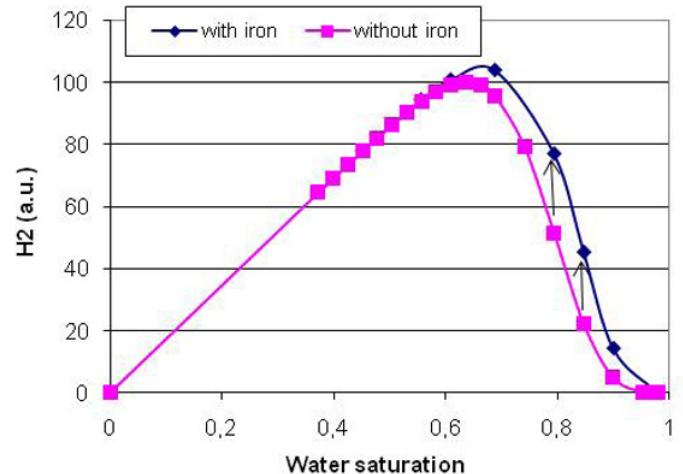
Fig. 5: Dihydrogen production for 100 years as a function of saturation, in the presence and absence of iron. At low saturation, gas transfer prevails and dihydrogen moves easily from the liquid phase to the gas phase. Therefore, in both cases (with or without iron), the efficiency of radiolytic recycling is very low and iron has no significant